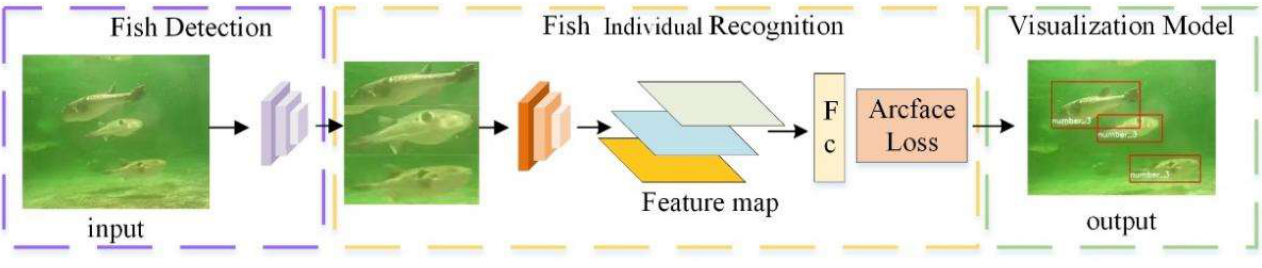
Figure 3. LIFRNet network structure.